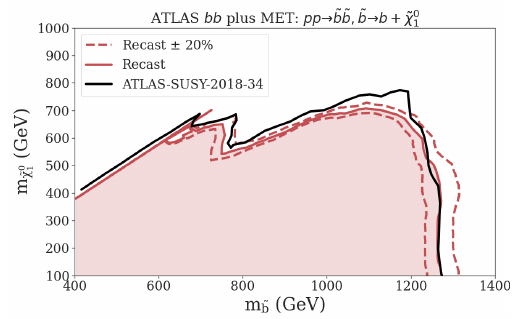
Figure 20 . Validation of the ATLAS search for b -jets plus MET [57] as implemented in the SModelS database. The solid black line shows the official exclusion curve for the sbottom simplified model considered by the ATLAS collaboration, while the solid red curve shows the corresponding curve obtained through